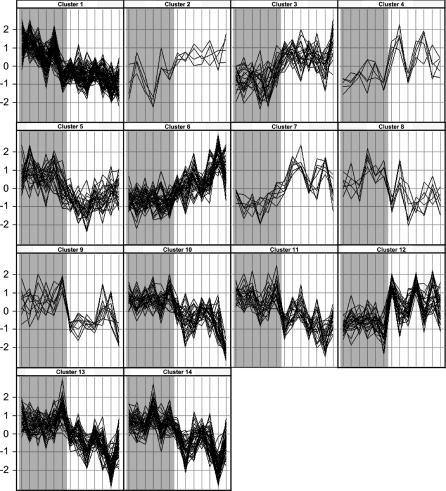
Profiles of Gene Expression in the Uterine Lower Segment from Women before or after the Onset of LaborEach panel shows profiles of the genes within one of the clusters determined jointly by K-means and hierarchical clustering. On the
x-axis, samples from individual patients are arranged and represented by vertical lines. Non-labor samples (gray background) are shown on the left and labor (white background) on the right. The
y-axis represents the level of gene expression as a number of standard deviations from the mean of all observations for each gene (
z-score).